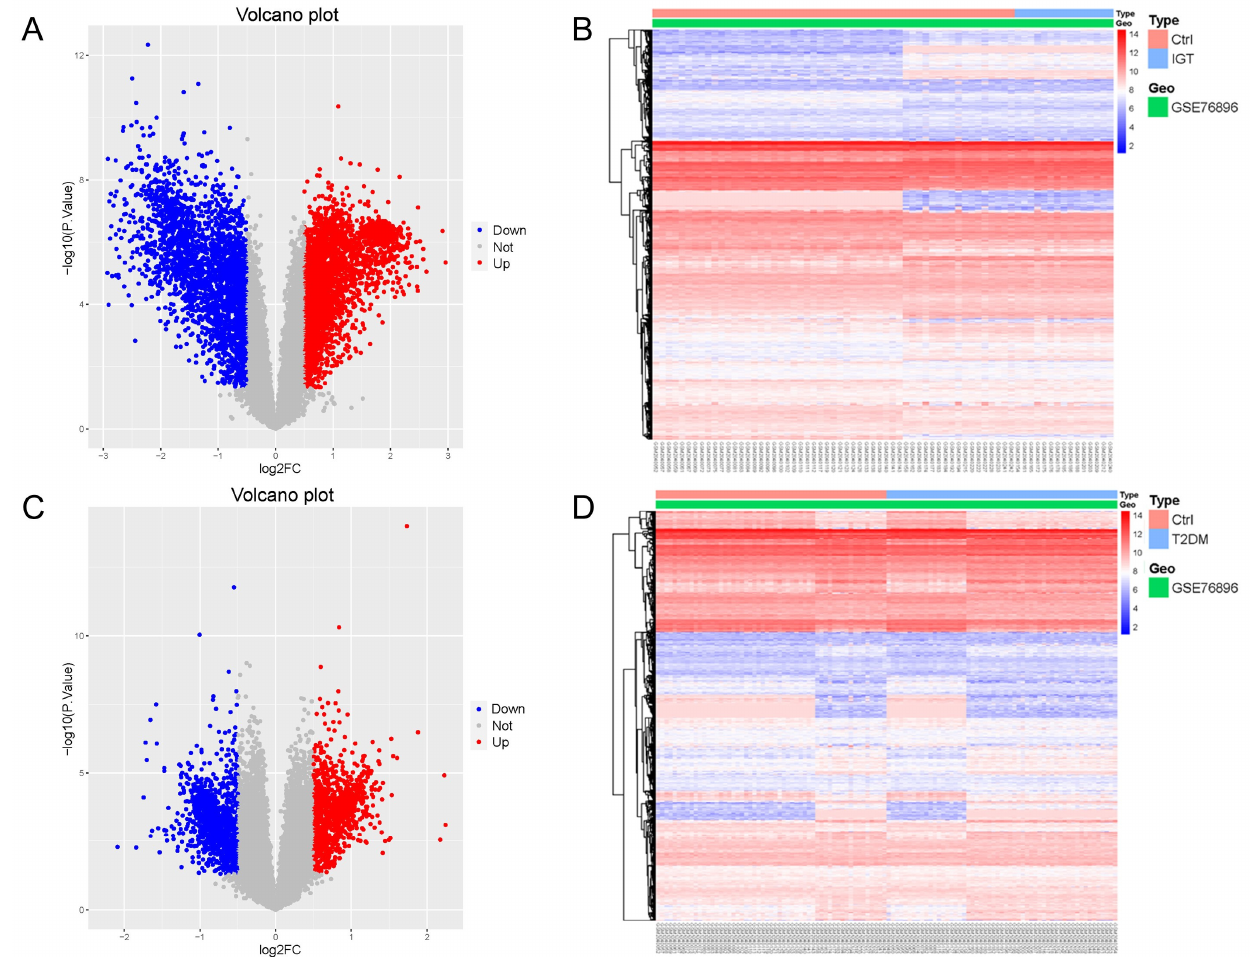
Figure 1. Volcano map ( A , C ) and heat map ( B , D ) of DEGs for IGT and T2DM.